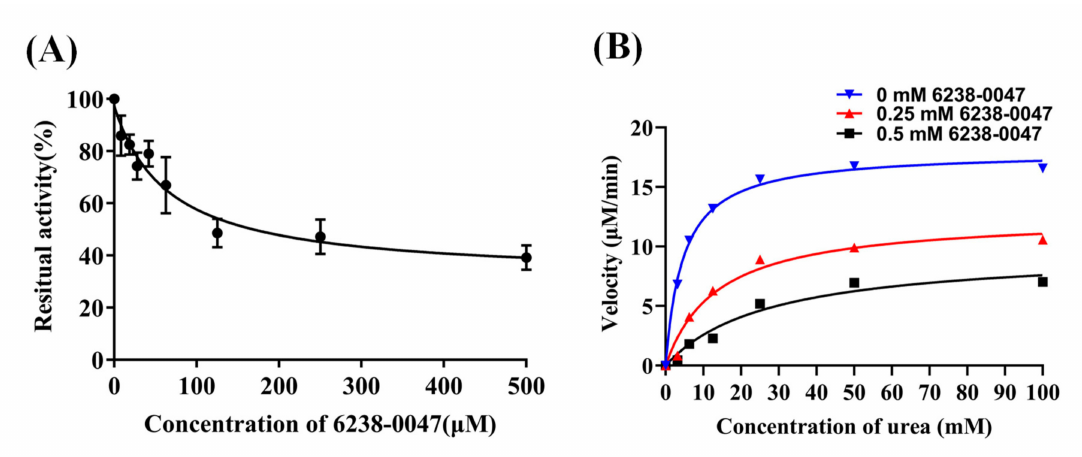
Figure 3. IC 50 identification ( A ) and kinetic characterization ( B ) of compound 6238-0047 against ruminal microbial